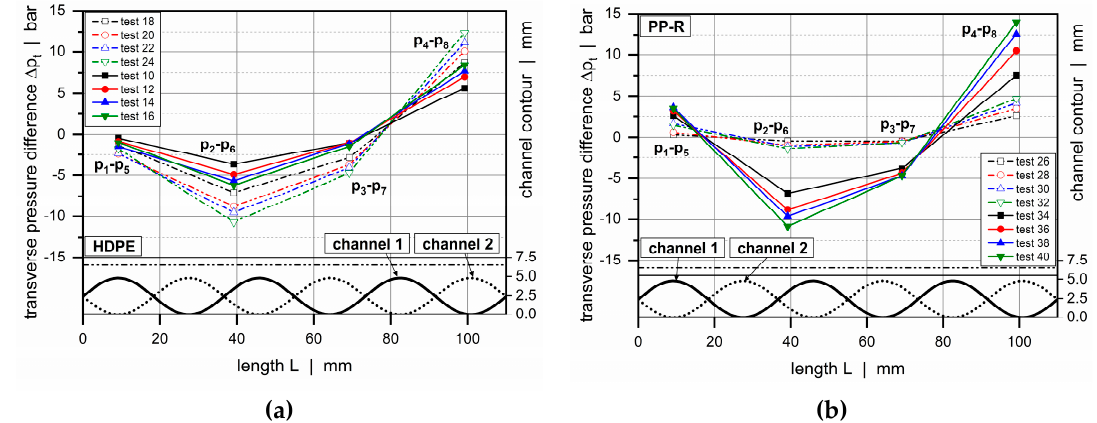
Figure 15. Transverse pressure difference between channel 2 and channel 1 for various test configurations: HDPE (a) and PP-R (b).